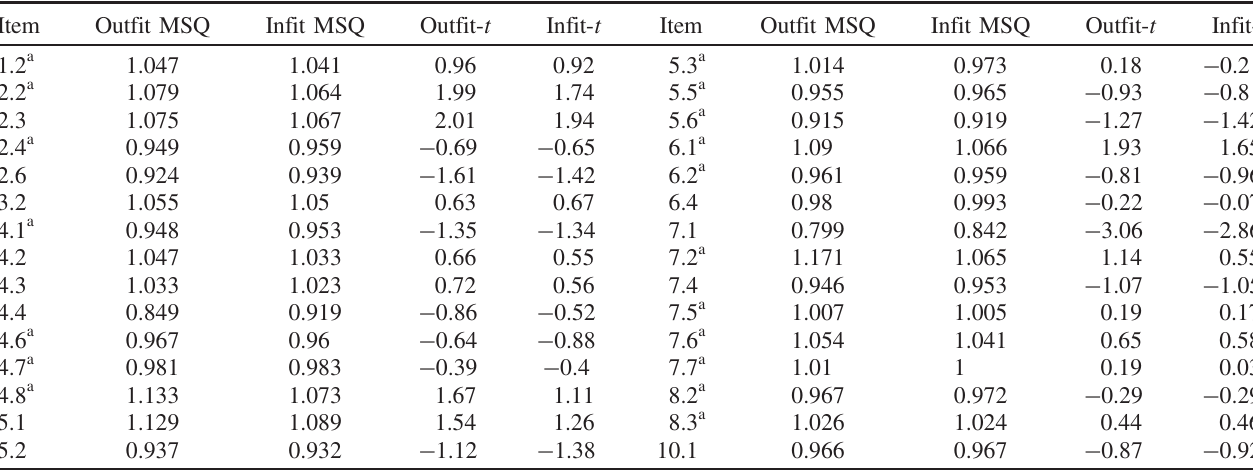
TABLE IV. Item fit statistics for the CML Rasch calibrated PSCI-ALPHA. MSQ ¼ mean square, Outfit MSQ ¼ the sum of the squared standardized residuals averaged over all the persons taking the test, Infit MSQ ¼ the weighted average of the squares of the residuals (it must be close to 1 for a good fit), Outfit- t ¼ chi-square-like statistic for Outfit MSQ, Infit- t ¼ chi-square-like statistic for Infit MSQ.